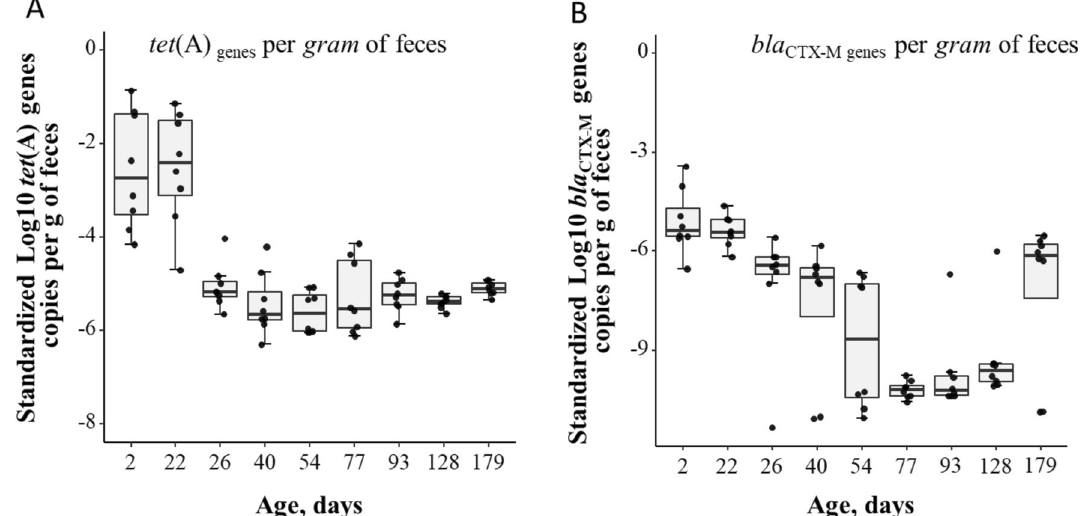
Fig. 4 Standardized mean log 10 copies of resistance genes. A tetracycline tet (A), and B 3rd generation cephalosporin bla CTX-M genes per gram of wet fecal samples from pigs at different ages. Non-zero values (log10